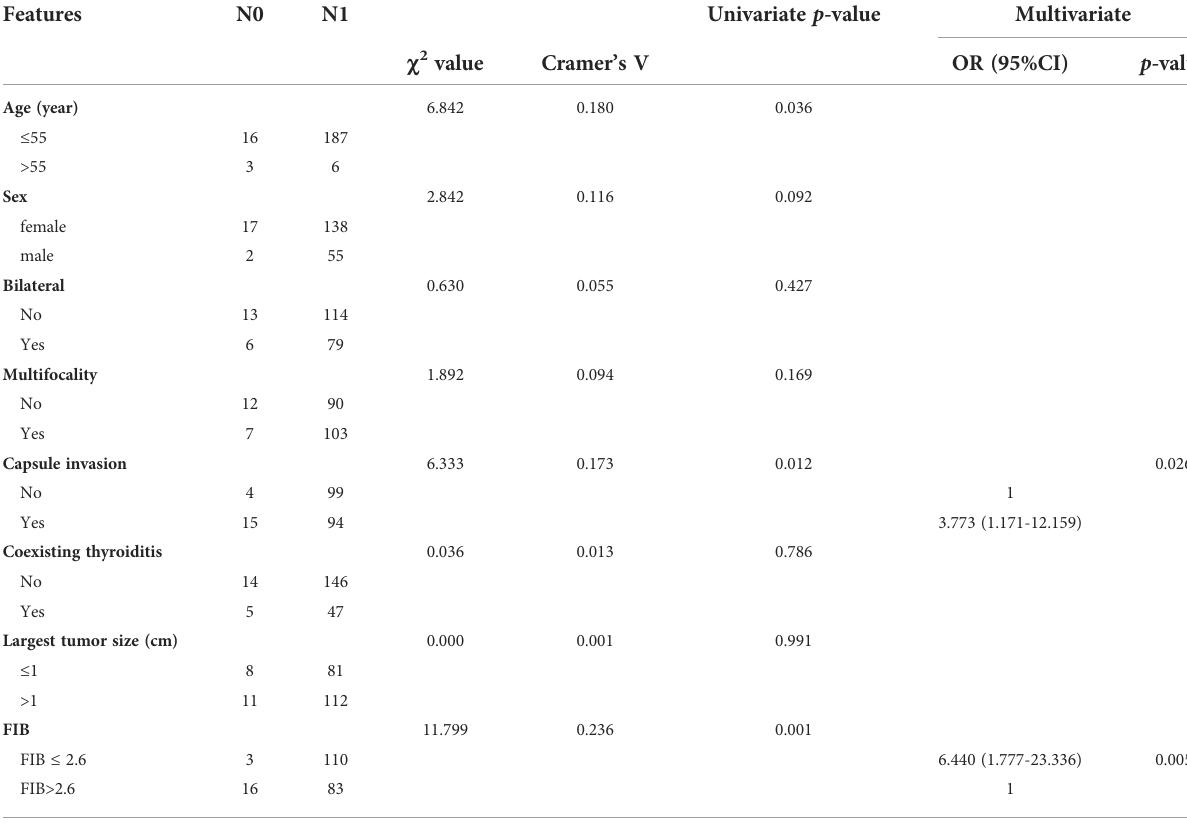
TABLE 3 Univariate and multivariate regression analyses of the possible risk factors for LN metastasis.